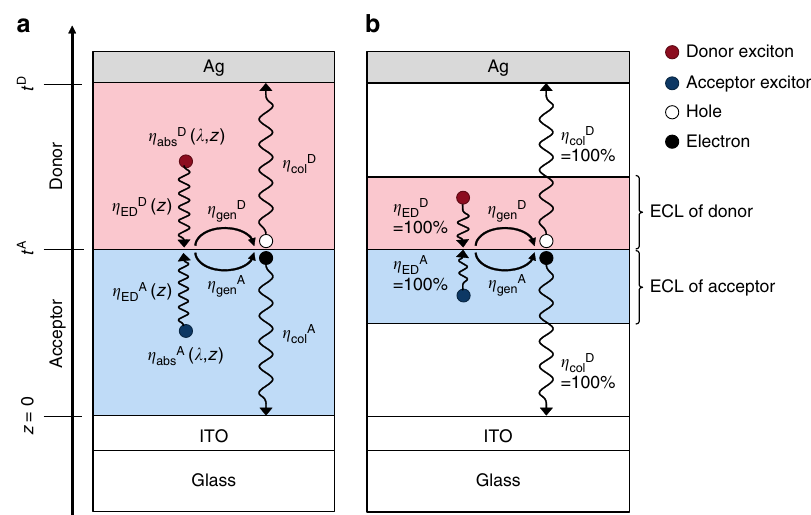
Fig. 3 Schematic illustrations of the charge generation process. a Schematic of the processes with their ef fi ciencies ( η ), where the superscripts D and A indicate that the process occurs in the donor and the acceptor, respectively. Upon light irradiation, the excitons are generated with ef fi ciency η abs ( λ , z ) and diffuse to reach the D/A interface with ef fi ciency η ED ( z ). The excitons are converted into free charges with ef fi ciency η gen and collected in each electrode with ef fi ciency η col . b Schematic of the assumptions in this study used to reproduce the experimental external quantum ef fi ciency spectra. All the excitons generated around the D/A interface within the exciton collection length (ECL) reach the interface ( η ED = 100% within ECL and η ED = 0% outside ECL) and all the generated charges are collected by the electrodes ( η col = 100%) (see Supplementary Fig.